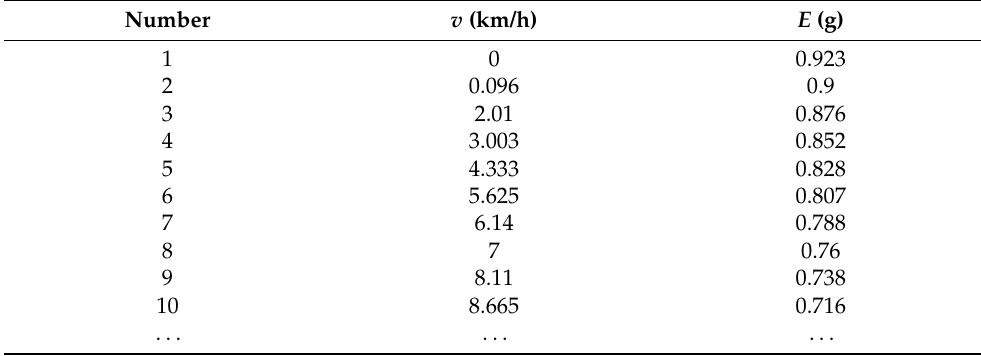
Table A5. Relationship between carbon emissions and velocity